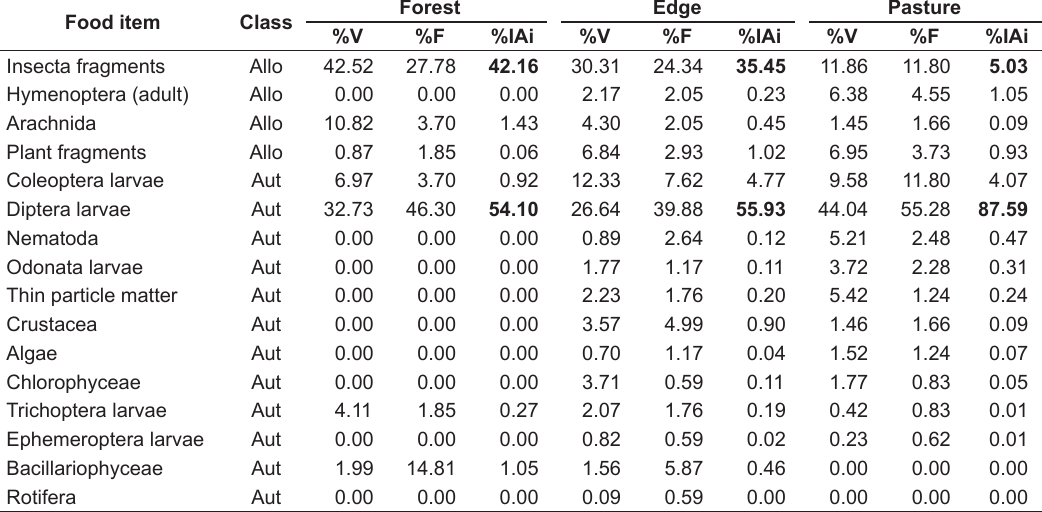
Table 2. Composition of stomach contents of Aequidens tetramerus individuals from the forest, edge, and pasture areas. Forest Edge Pasture Food item Class Insecta fragments